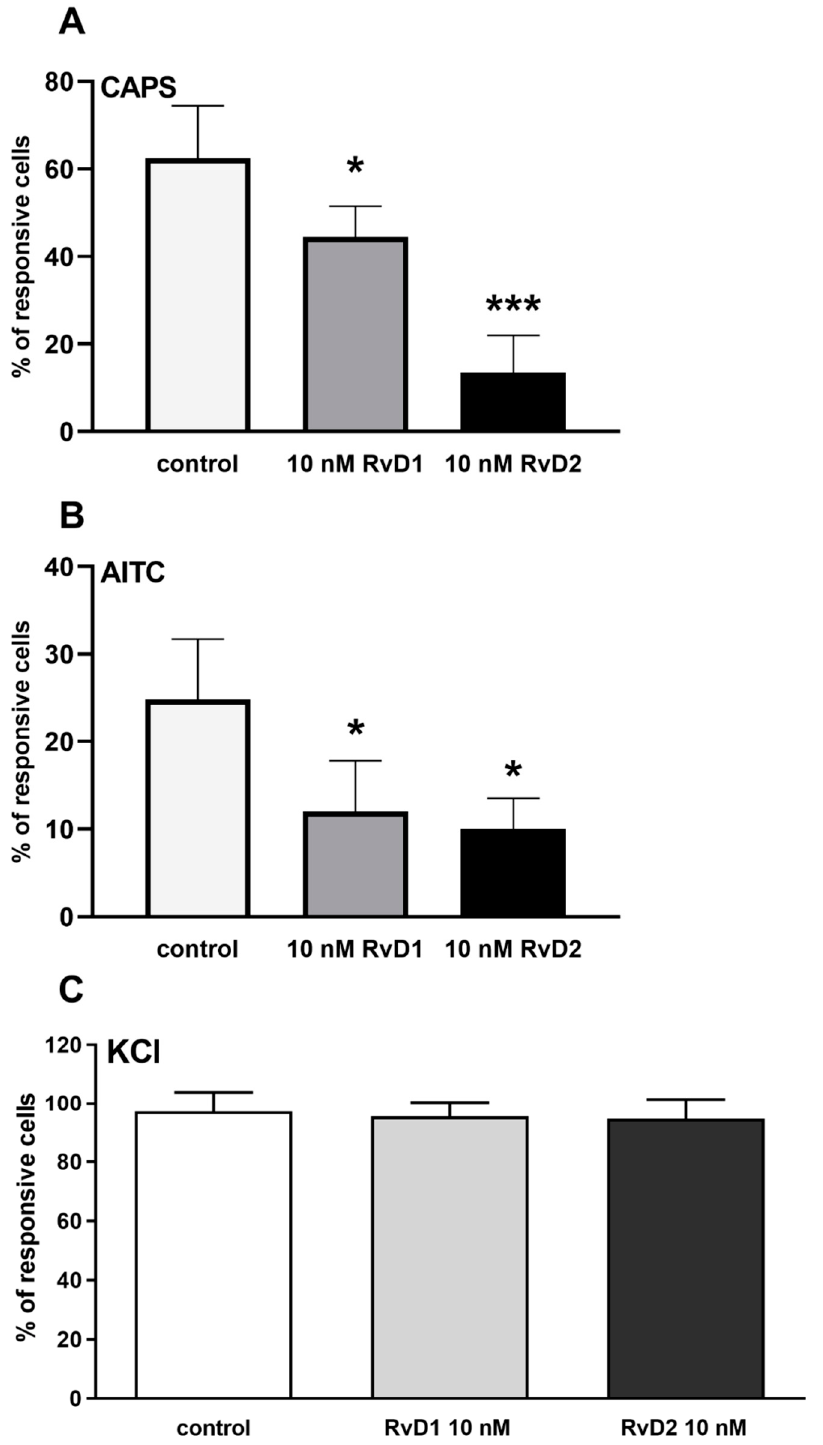
Figure 4. E ff ect of RvD1 and RvD2 on TRPV1 and TRPA1 receptor activation on cultured TG sensory neurons after PTX treatment and on KCl-evoked voltage gated Ca 2 + channel activation. ( A ): The percentage of responsive cells to CAPS is presented after RvD1 or RvD2 (both of them 10 nM) administration. ( B ): The percentage of responsive cells to AITC is presented after RvD1 or RvD2 (both of them 10 nM) administration. ( C ): The percentage of responsive cells to KCl is presented after RvD1 or RvD2 (both of them 10 nM) administration. (* p < 0.05, *** p < 0.001 (control vs. treated, one-way ANOVA, Dunnett’s post hoc